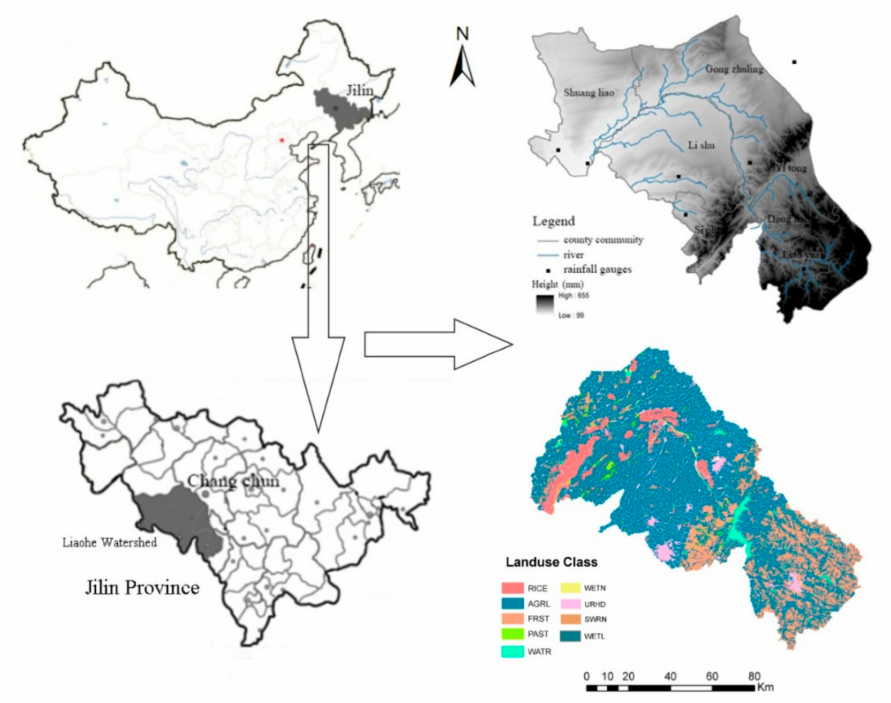
Figure 1. The location, elevation, and land use of the Liao River source